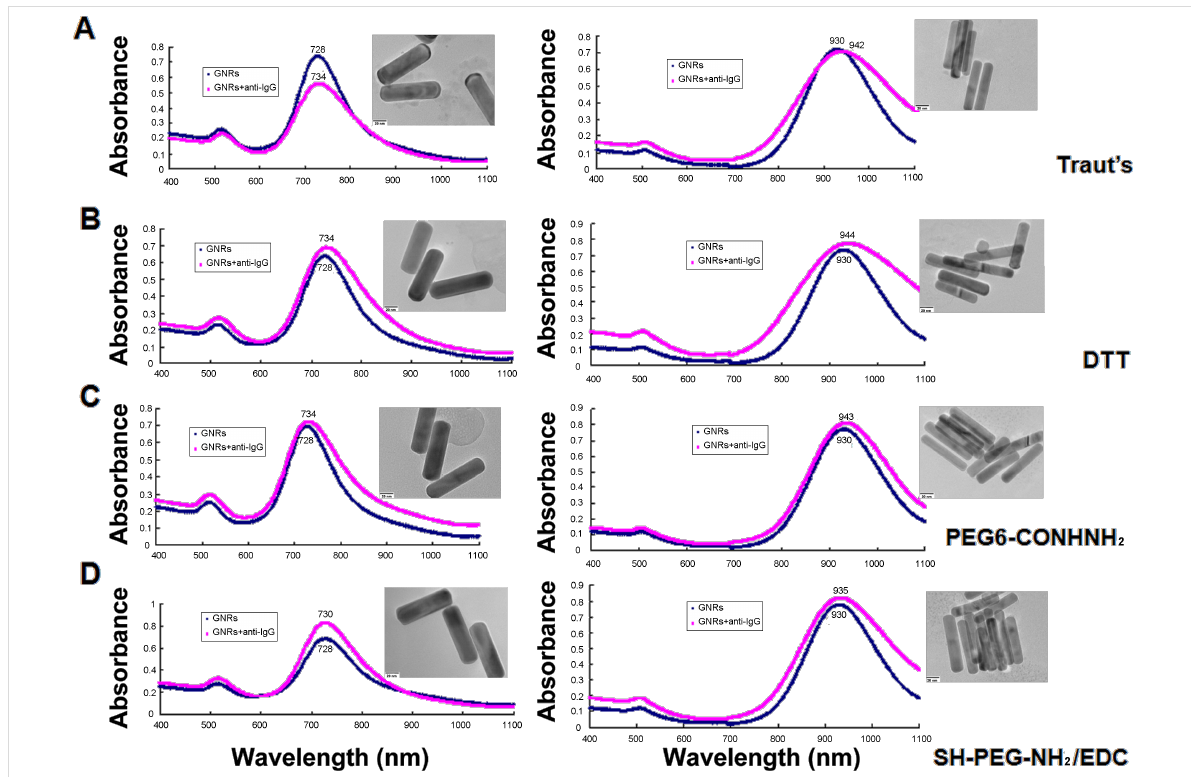
Figure 2: Absorption spectra before and after GNR functionalization with a longitudinal SPR peak wavelength at 728 and 930 nm, respectively, using (A) Traut’s reagent, (B) DTT, (C) PEG6-CONHNH 2 , and (D) SH-PEG-NH 2 combined with EDC reaction to introduce thiol groups to anti-IgG. A red shift was observed upon binding for all thiolation methods. Inset: TEM images of conjugated